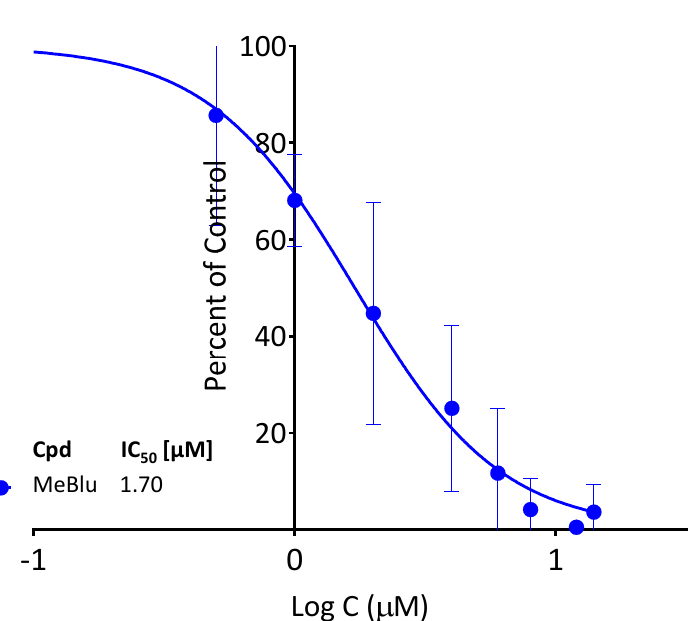
Figure 7. Concentration-dependent inhibition of SARS-CoV-2 replication in Vero E6 cells by MeBlu. Vero E6 cells were infected with SARS-CoV-2 at an MOI of 0.01; treatments were performed for 48 h as described in the Methods. The viral yield in cell supernatant was quantified by droplet-digital PCR.